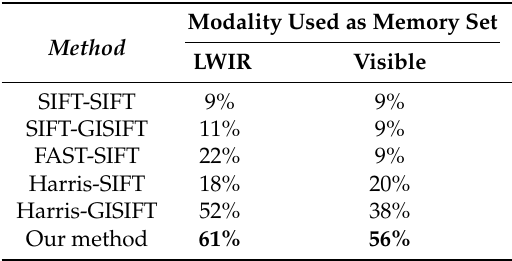
Table 2. Results (matching ratio) on Barcelona dataset.